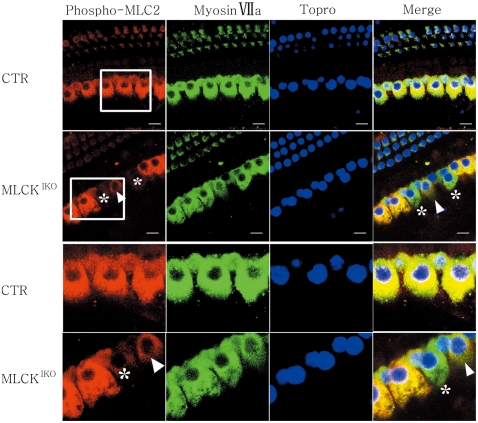
Immunohistochemistry of phospho-MLC2 and myosin VIIa in the basilar epithelium.In MLCKIKO mouse cochleae, the phospho-MLC2 signal (red) (asterisks and arrowhead) in 60–70% of IHCs was weaker than that of the CTR IHCs, whereas myosin VIIa staining (green) was similar in both CTR and MLCKIKO IHCs. The nuclei were stained (blue) with Topro. Scale bars: 10 µm.